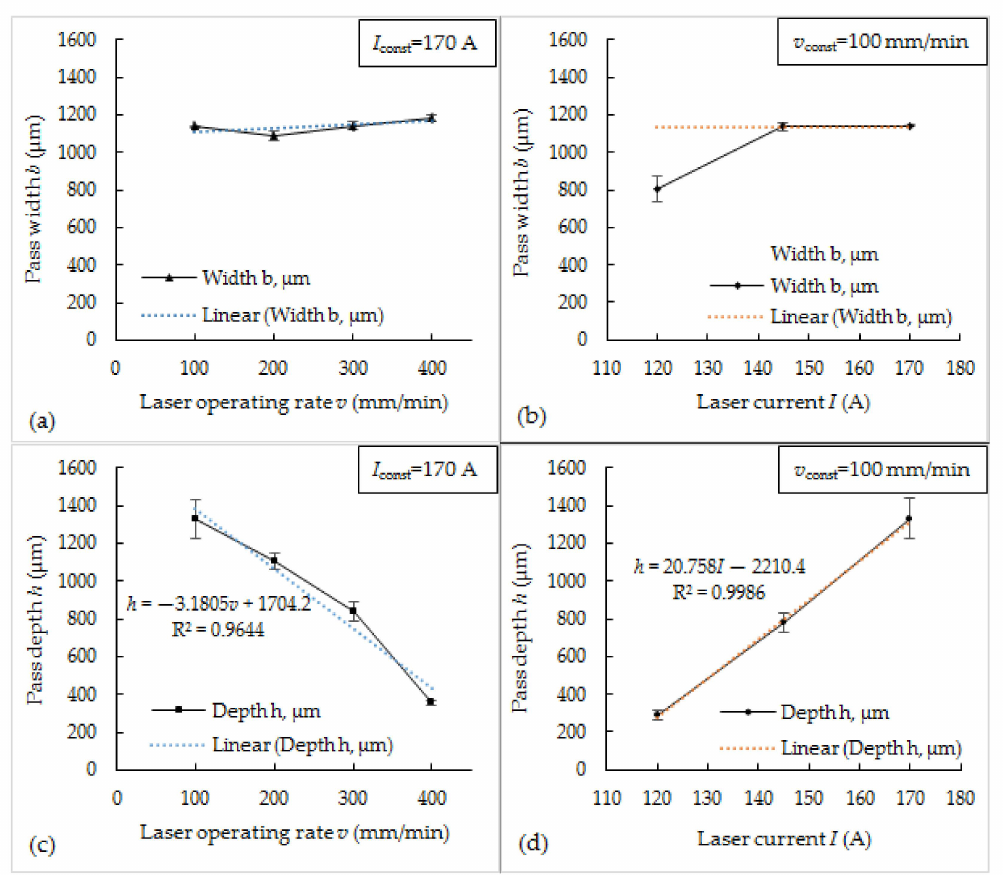
Figure 2. Pass width ( a , b ) and depth ( c , d ) dependencies on the laser operating rate (at a constant 170 A laser current) and laser current (at a constant operating rate 100